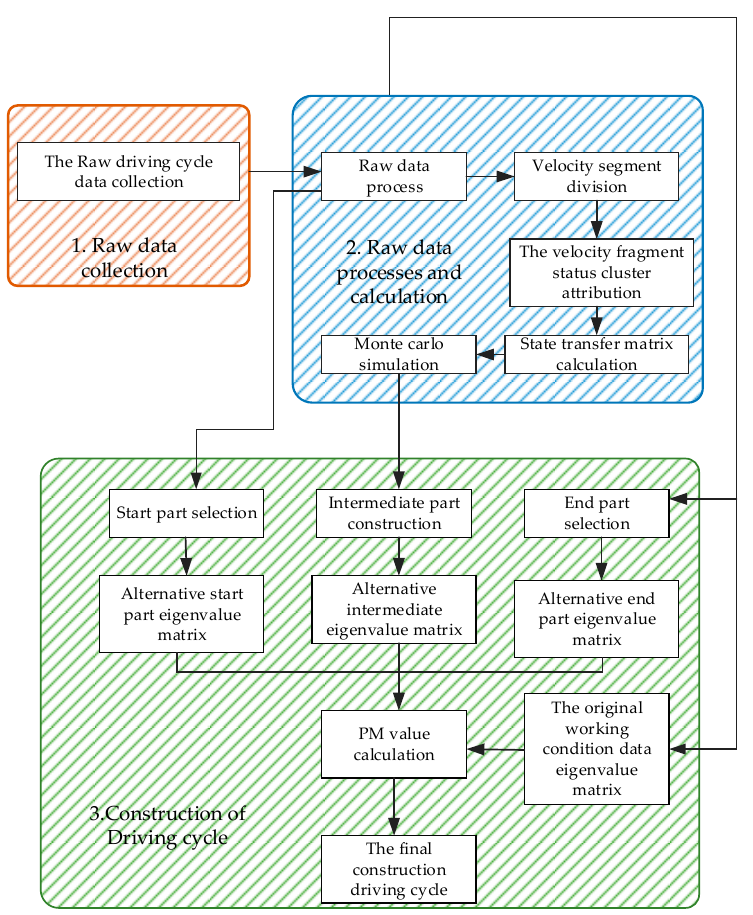
Figure 3. Flowchart of the driving cycle construction based on the Markov chain.